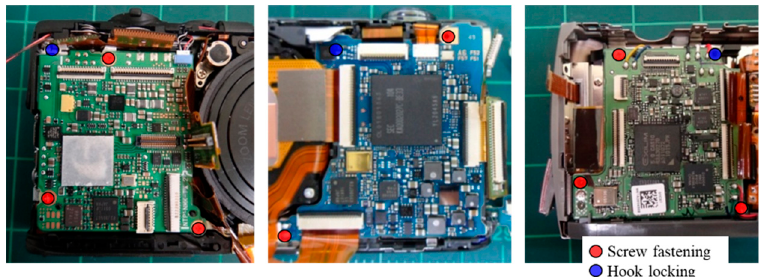
Figure 1. Various printed board assembly (PBA) mounting structures for portable electronics.